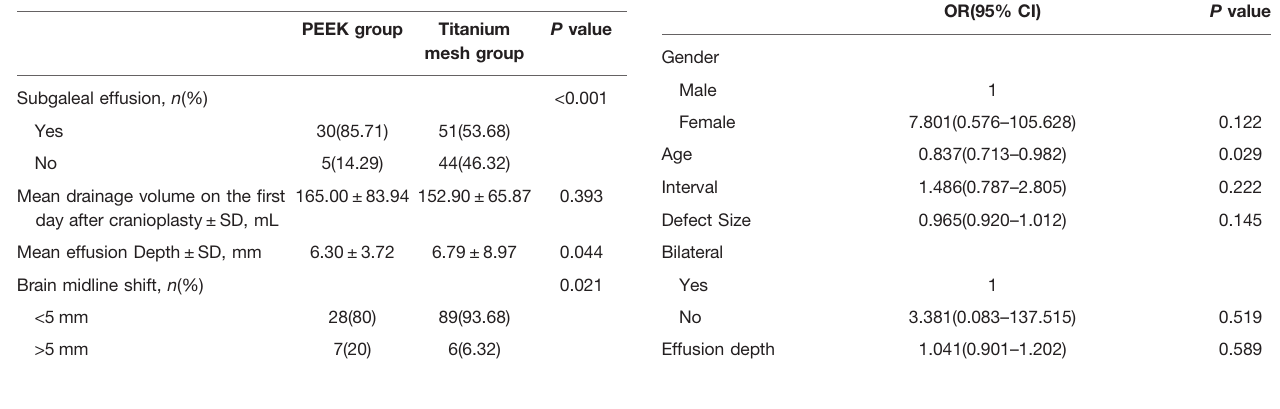
TABLE 2 | Subgaleal effusion and brain midline shift in the PEEK and Titanium groups.